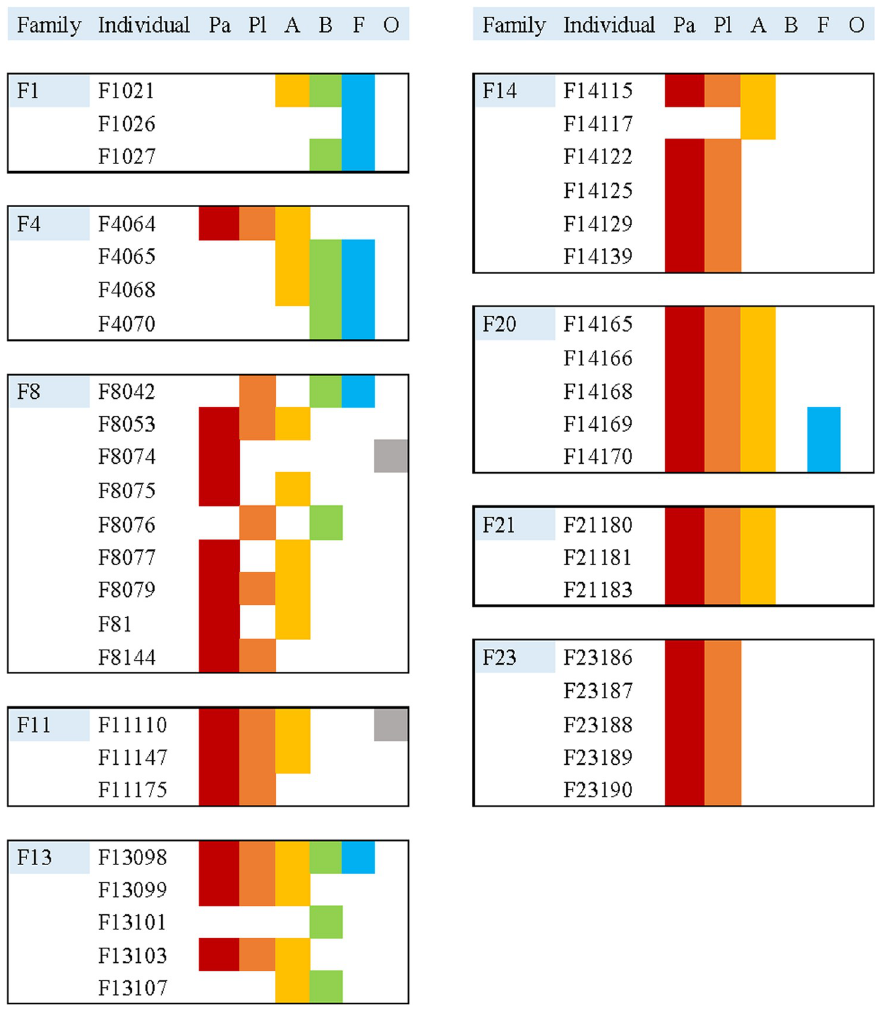
Fig 1. Distribution of affected body areas within families with primary focal hyperhidrosis. Only individuals with known sites were considered. A: Axillary; B: Back; F: Facial; O: Other; Pa: Palmar; Pl: Plantar.